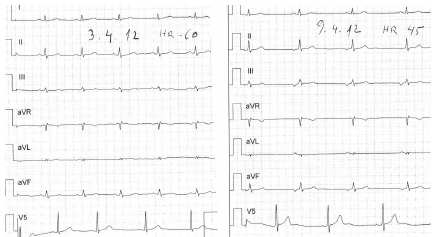
Figure 1: EKG: note the bradycardia and inverted P waves (II; III; AVF) 6 days following admission.